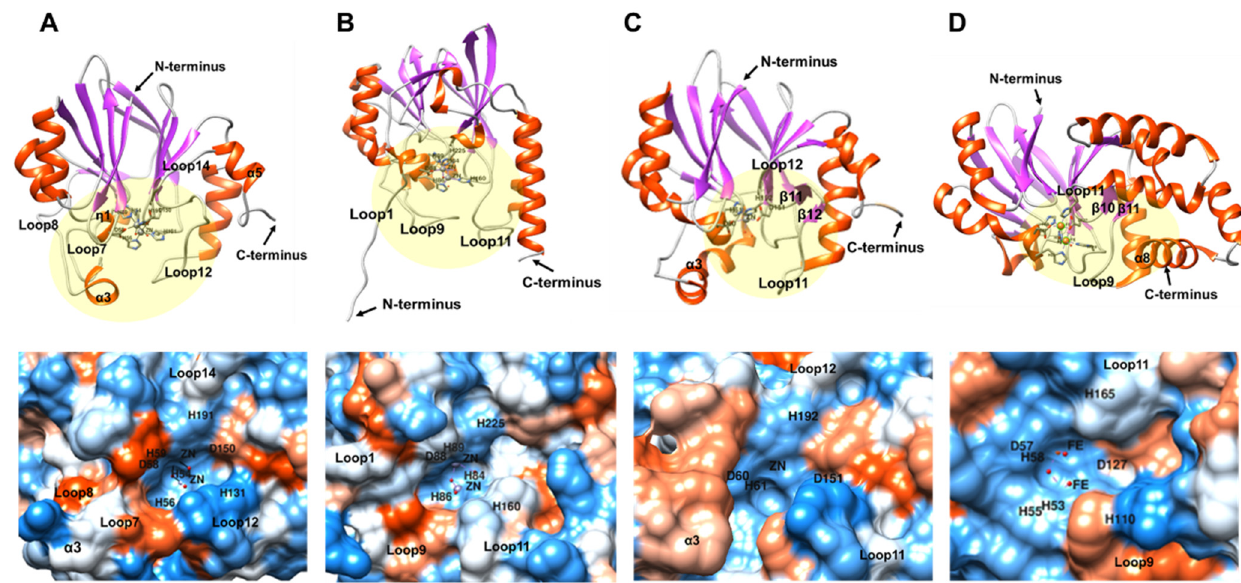
Figure 9. Crystal structures illustrated in ribbon view with active site indicated by yellow circle ( top ) and surface depiction of active-site groove colored in hydrophobicity scale (blue for the most hydrophilic, white to red for the most hydrophobic) ( bottom ) of ( A ) BLEG-1; ( B ) L1 MBL (PDB ID: 1SML, chain A); ( C ) YcbL (PDB ID: 2XF4, chain A); and ( D ) GloB GLXII (PDB ID: 2QED, chain A).